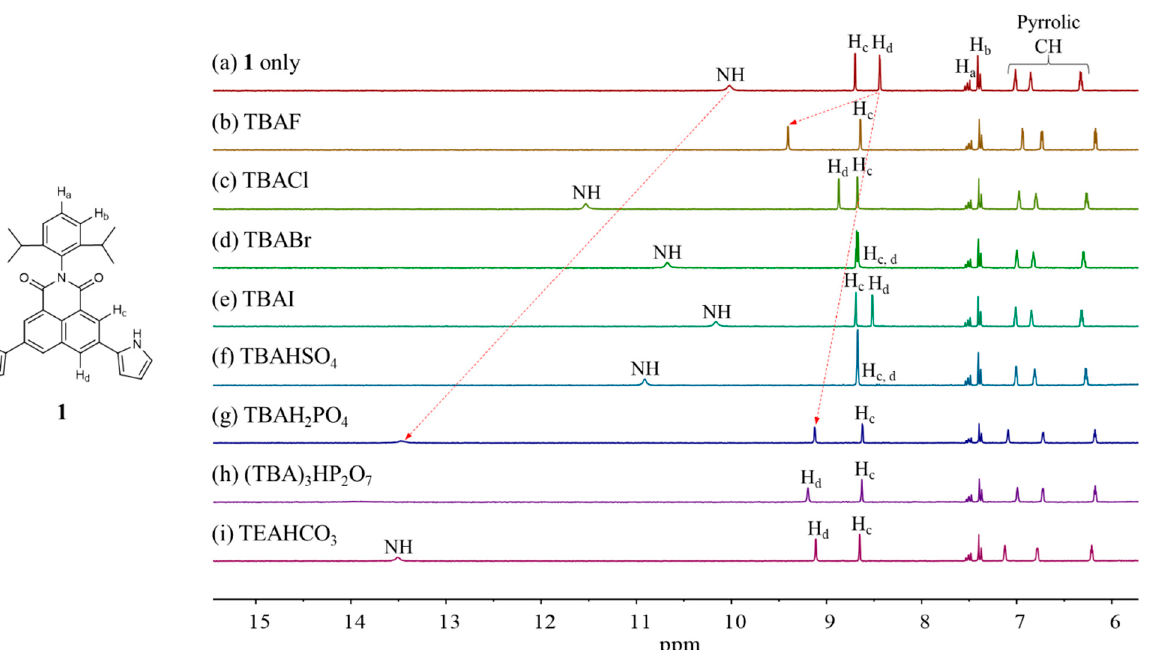
Figure 5. Partial 1 H NMR spectra of (a) 2 (3 mM) only, (b) 2 + excess TBAF, (c) 2 + excess TBACl, (d) 2 + excess TBABr, (e) 2 + excess TBAI, (f) 2 + excess TBAHSO 4 , (g) 2 + excess TBAH 2 PO 4 , (h) 2 + excess (TBA) 3 HP 2 O 7 , and (i) 2 + excess TEAHCO 3 in CD 3 CN. Detailed 1 H NMR spectroscopic titrations of receptors 1 and 2 with the test anions were carried out in CD 3 CN to quantify their binding affinity for the anions under study. For instance, upon the subjection of receptor 1 to titration with the fluoride anion, the proton signals corresponding to the pyrrole NHs and the naphthalene imide CHs (H d )